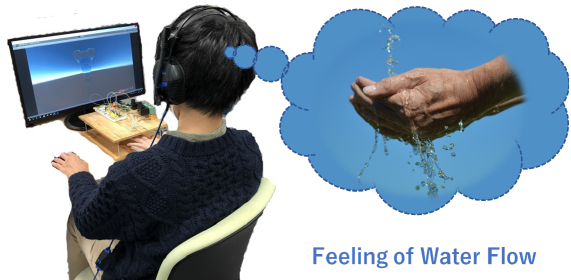
Figure 1. Our prototype FlowHaptics , which produces midair haptic feedback to replicate the sen- sation of flowing water. Although the feeling of flowing water is composed of multiple sensations, such as viscosity and temperature, we focused on pressure, including the drag over the fingers and skin